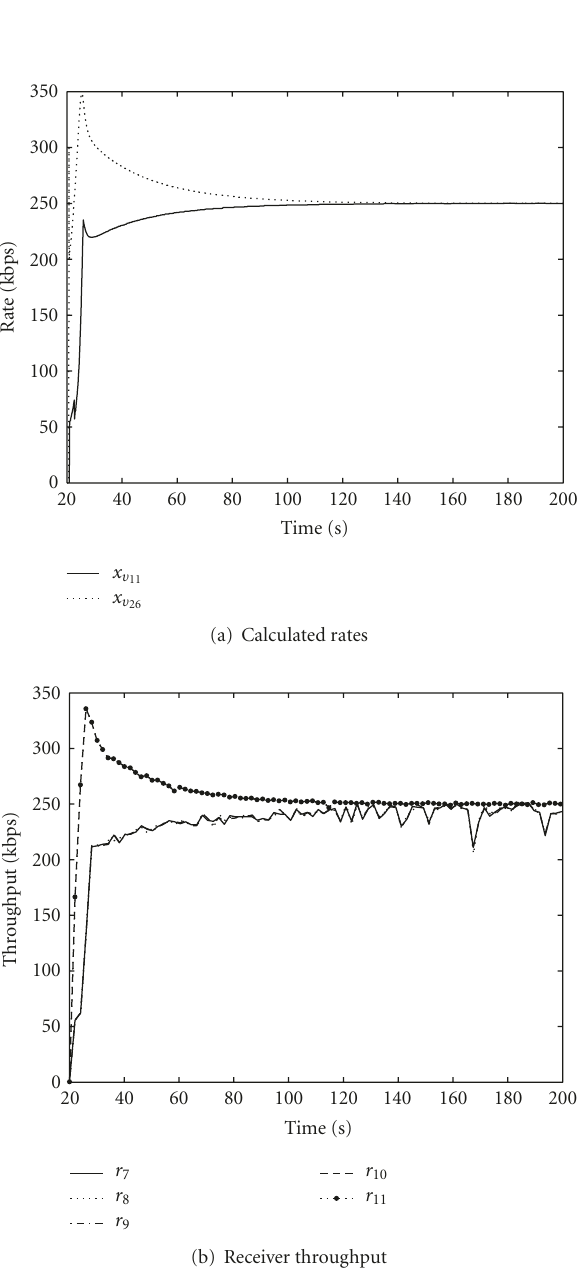
Figure 13: Case 1 (unirate): calculated rate and throughput without using gateway node υ 14